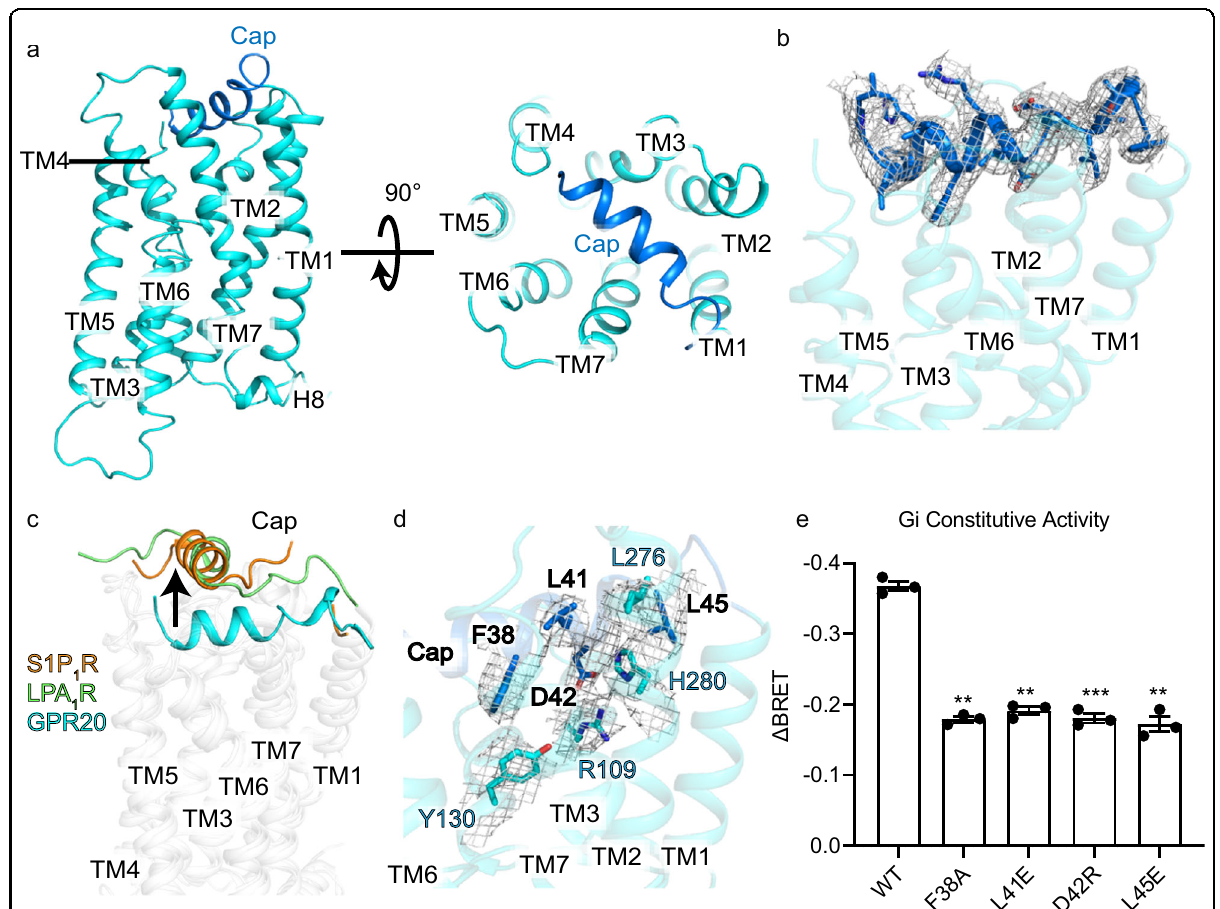
Fig. 2 Unique N-terminal region of GPR20. a Two orthogonal views of the cartoon representation of GPR20 (cyan) to show the α -helical N-terminal cap (blue). b The electron density (gray mesh) of the N-terminal cap region is shown by overlying on the model. c Superposition of GPR20 (cyan), S1P 1 R (PDB 7TD3, orange) and LPA 1 R (PDB 7TD0, green) structures to show the respective position of the N-terminal cap in each structure (all aligned to β 2 AR structure (PDB: 3SN6), the C α atoms of the residues embedded deepest in the pocket were used: F38 for GPR20, Y34 for LPA 1 R and Y29 for